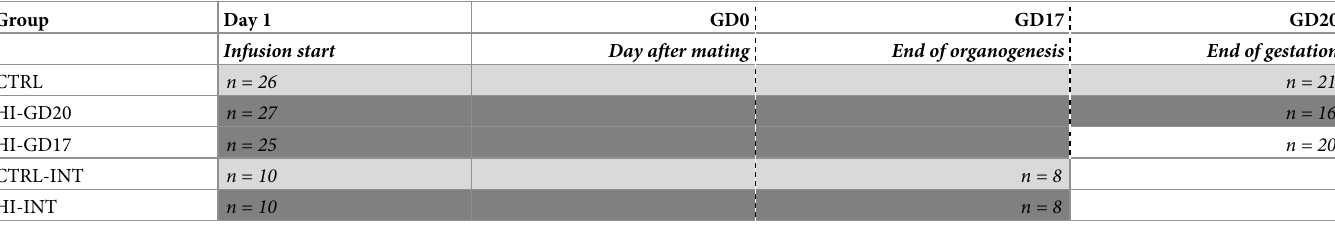
Dark grey areas: Infusion with HI, light grey areas: Vehicle infusion. CTRL-INT and HI-INT groups were sacrificed on GD17, CTRL, HI-GD20, and HI-GD17 groups on GD20. Time-span from Day 1 (start of infusion) until mating (following day named GD0) was 8–14 days, depending on the oestrous cycle of the individual animal. CTRL, control. GD, gestation day. HI, human insulin. INT, intermediate. n refers to the total number of dams at infusion start (Day 1) and sacrifice (GD17 and